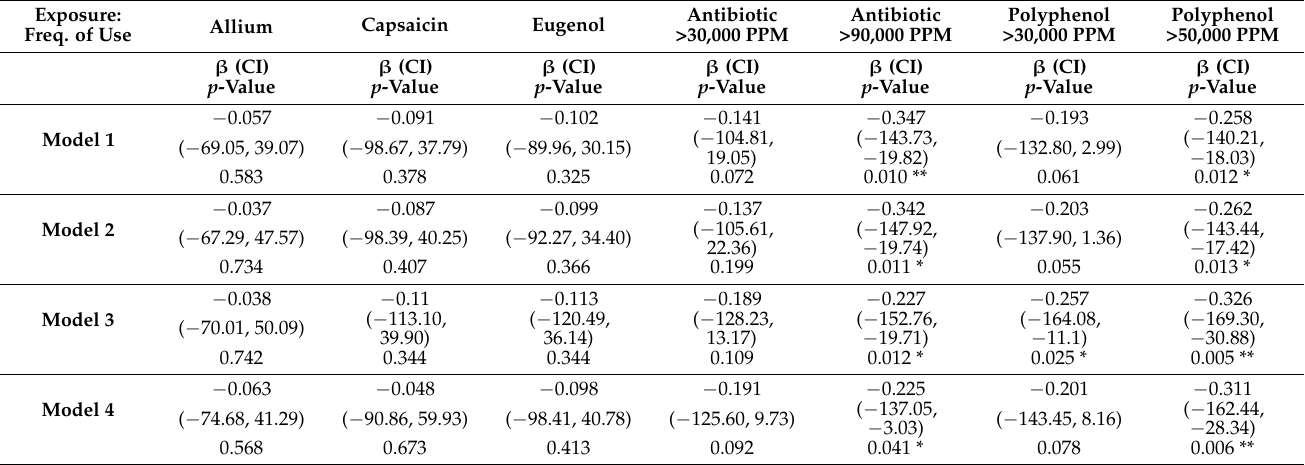
Table 8. Association between frequency of culinary herb use and Proteobacteria abundance.